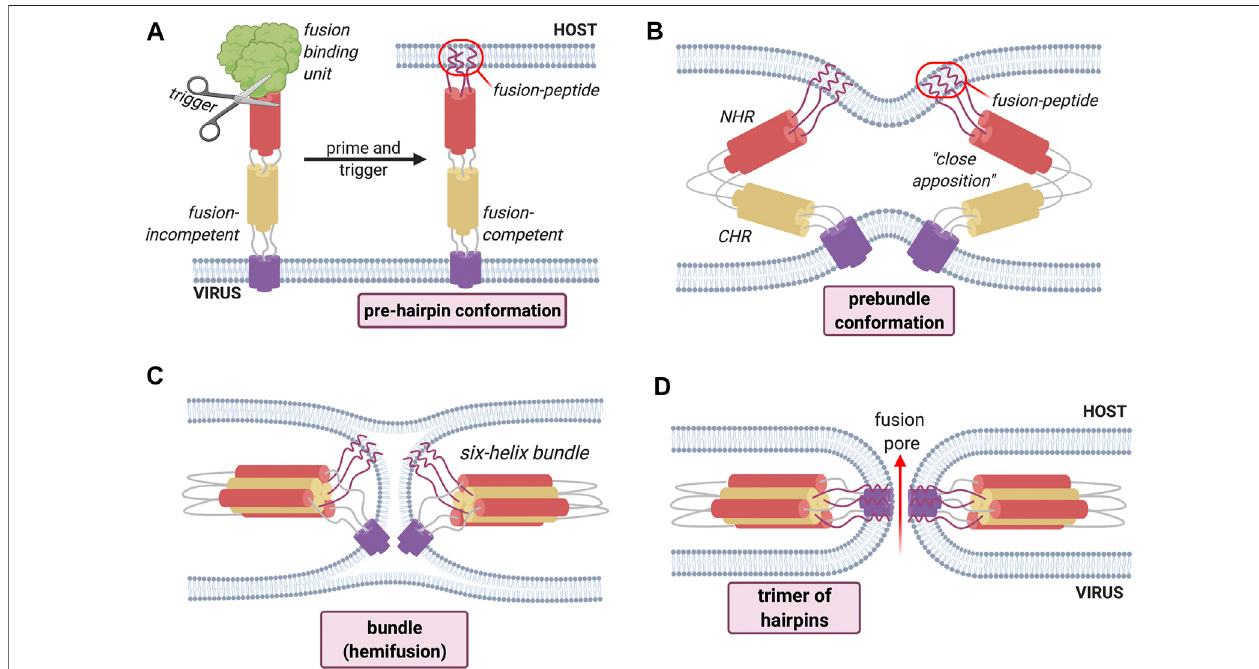
FIGURE2| GeneralmechanismoffusionprocessemployedbyClassIfusionproteins.AnenvironmentaltriggersuchasanacidicpHorthebindingtoacoreceptor (represented fi guratively by the scissors) induces a conformational change that exposes the fusion peptide (A) . The fusion peptide then inserts into the host cell membrane causing the fusion proteins to fold back on themselves, inducing the bending of apposed membranes (B) . The folding creates a contact between the membranes, leading fi rst to hemifusion (C) . Finally, the refolding leads to the formation of the fusion pore (D) and subsequent mixing of contents.